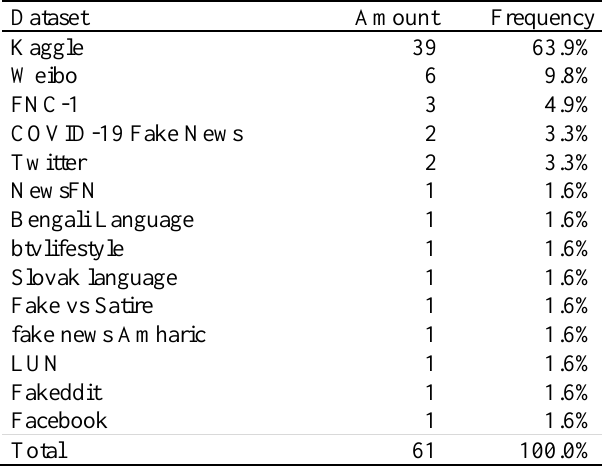
Table 4. Datasets used in the analyzed studies of fake news detection. Source: The authors.